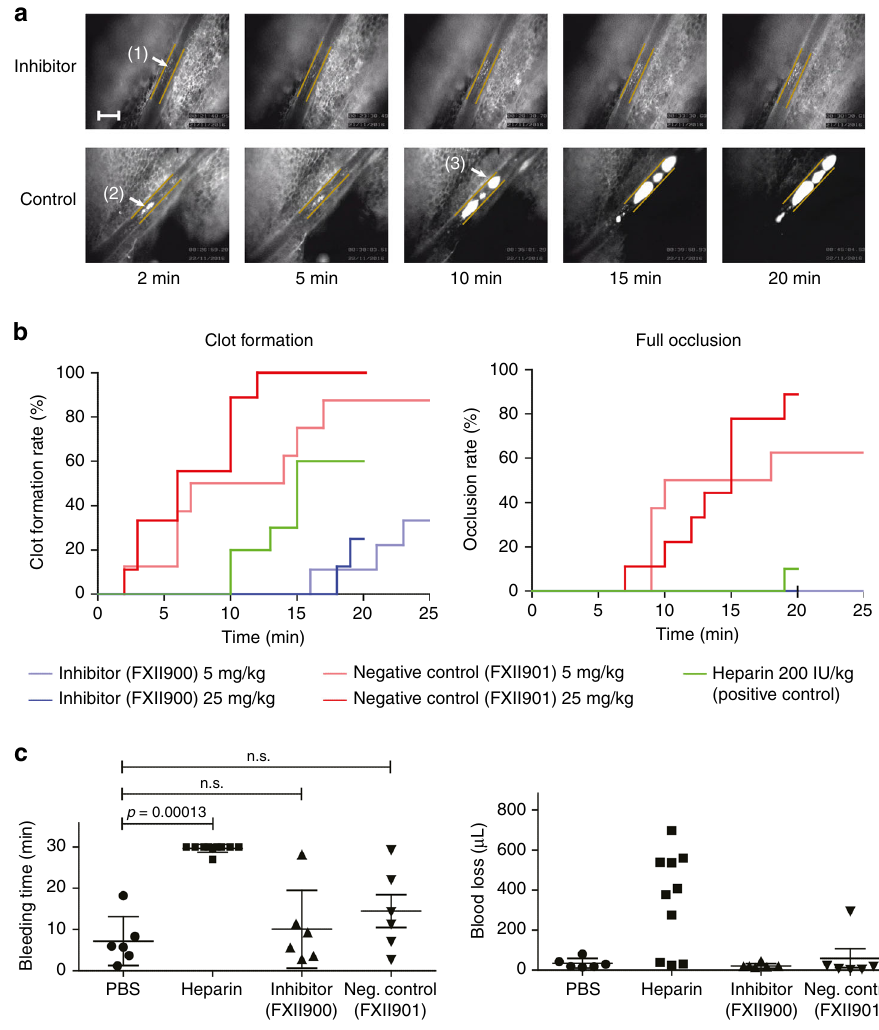
Fig. 4 Thromboprotection of FXII900 in mice and effect on bleeding. a Intravital fl uorescence microscopy images showing mesenteric arterioles in which thrombosis was induced by topical application of FeCl 3 (7.5%, 1 min). Platelets were fl uorescently labeled with Rhodamine 6G for visualization. Representative images are shown for two mice, one treated with FXII900 (upper panels) and one treated with inactive control peptide FXII901 (lower panels) 15 min before the application of ferric chloride (5 mg kg − 1 , subcutaneous injection). Vessel walls at the FeCl 3 application site are indicated with yellow markers. Three distinct morphological changes, (1) a characteristic speckled pattern, (2) clot formation, (3) and vessel occlusion, are indicated. Scale bar: 200 μ m. b The percentage of mice showing either clot formation or full occlusion at different time points after ferric chloride application